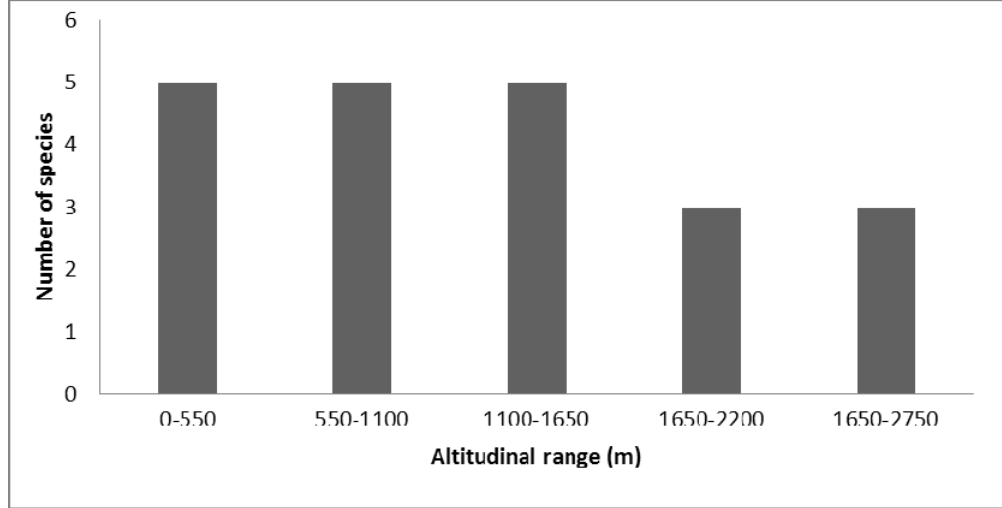
F IGURE . 4. Altitudinal distribution of bat species identified in the Ilam province. Rhinolophids bats ( Rhinolophus blasii , R . hipposideros and R . euryale ) except for R. ferrumequinum